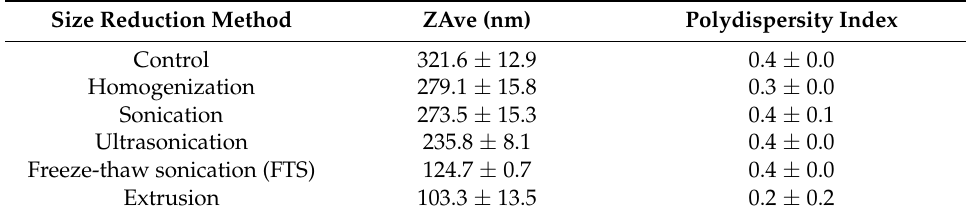
Table 1. Particle size of liposomes after treatment with various size reduction methods (Mean ± SEM, n = 6).